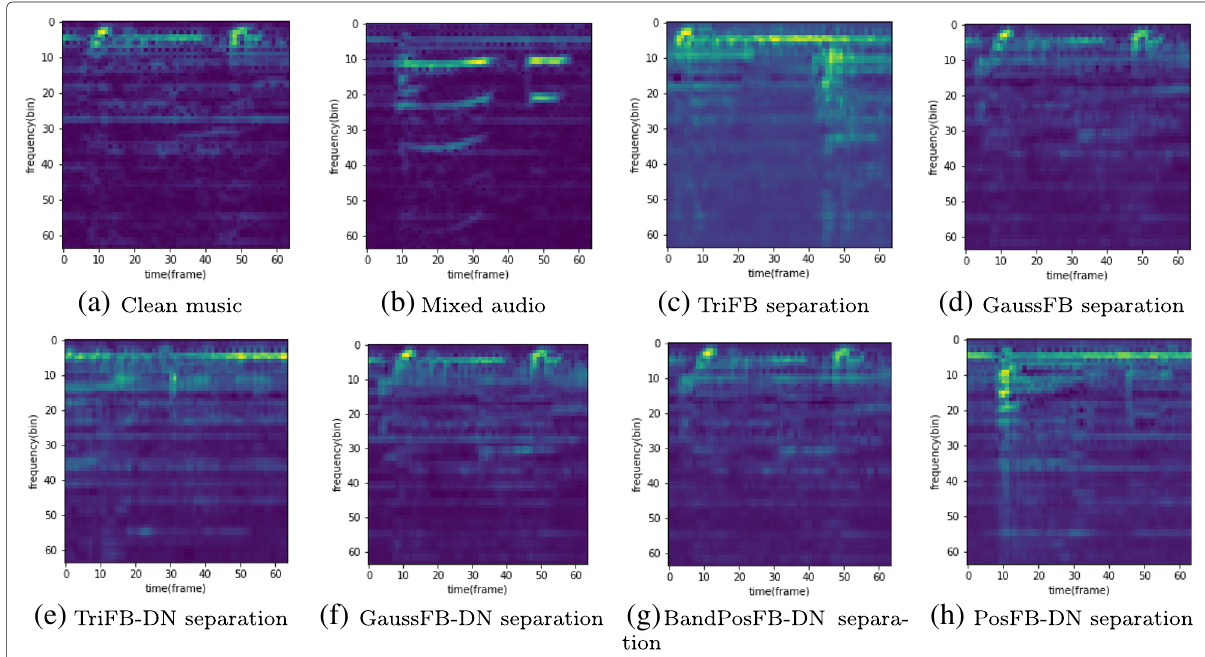
Fig. 7 Reconstructed spectrums of audio source separation tasks. The clean music spectrum in a is randomly selected from the dataset. b The corresponding music and vocal mixture. c – h The reconstructed music spectrums from the mixture spectrums using different filter bank